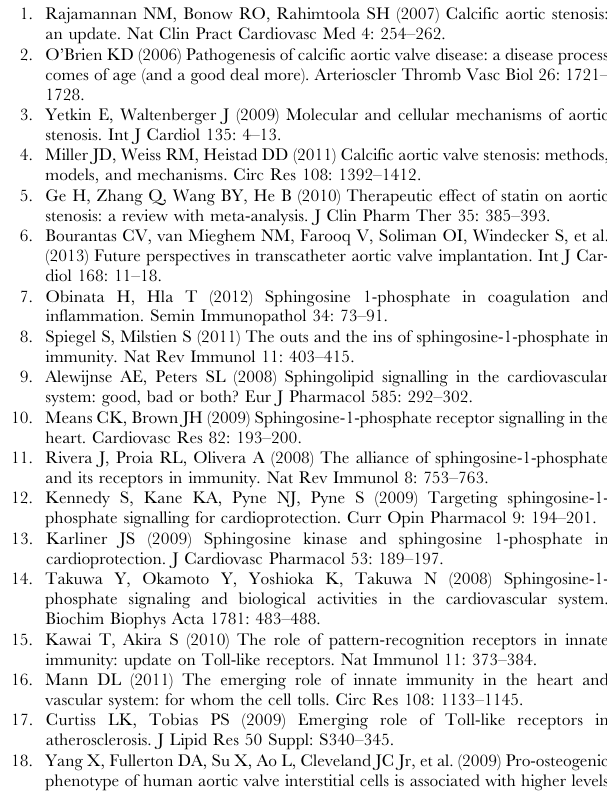
images from DAPI staining (nuclei). More than 95% cells in